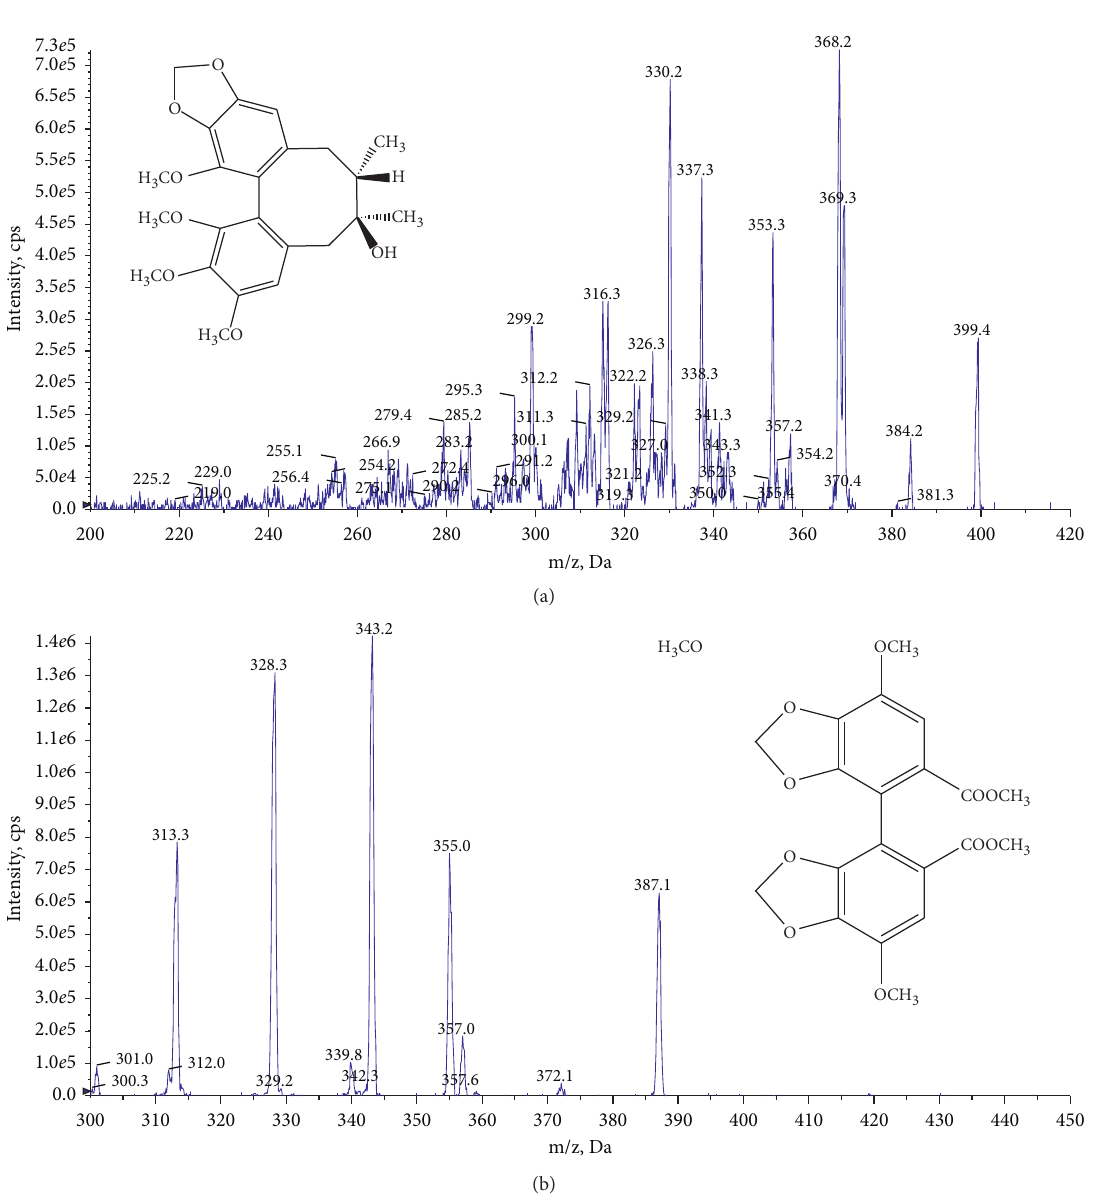
Figure 1: Representative multiple reaction monitoring chromatograms of Schisandrol B (a) and the internal standard bifendate